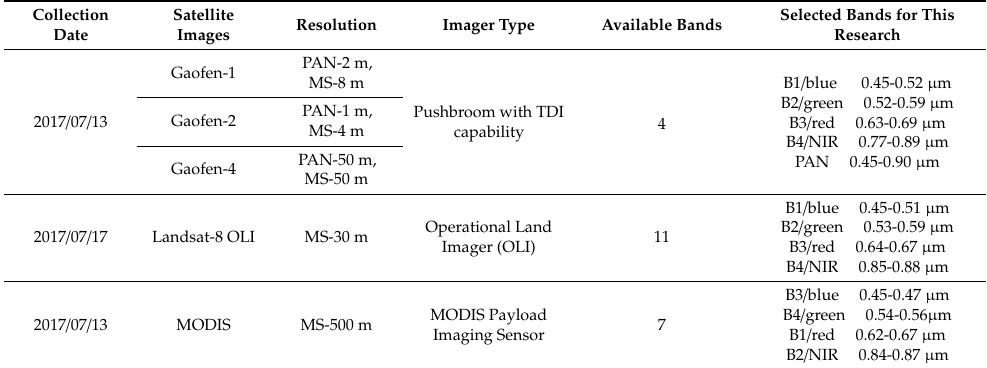
Table 1. Di ff erent images used for the